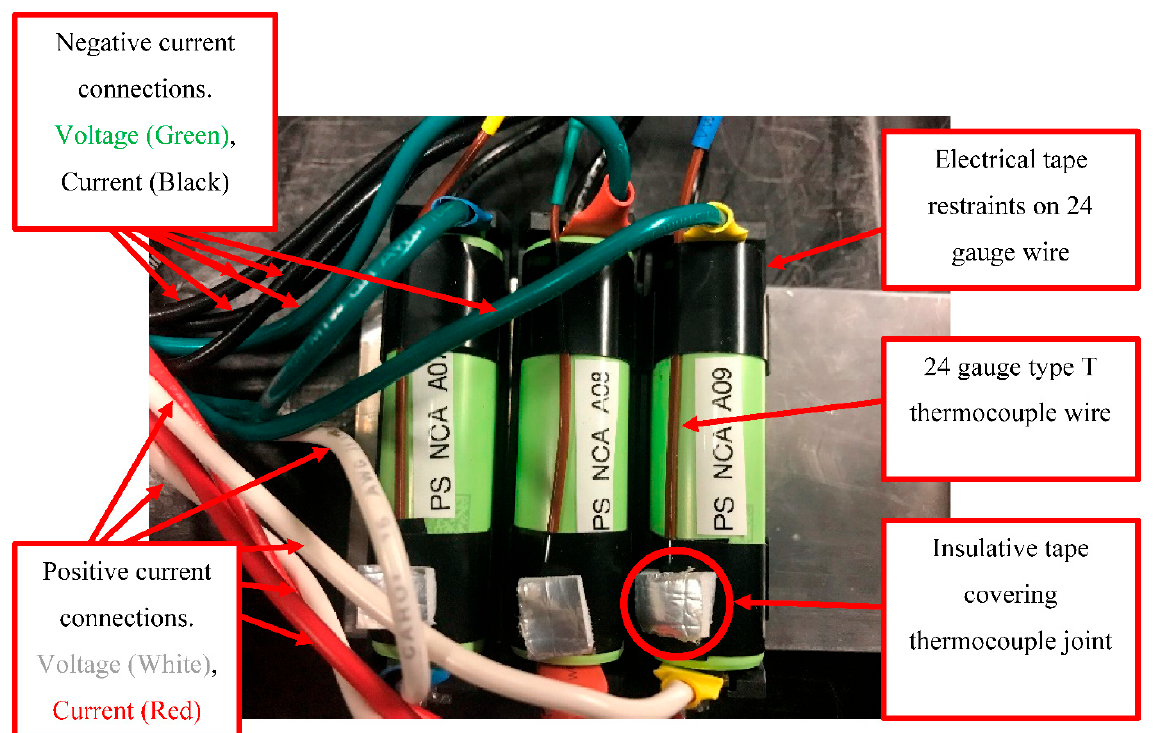
Figure 2. Experimental setup photograph of the interior of thermal chamber, with LEO condition test cells (0.2 kPa, 10 °C) in 3P groupings. Note that the test cells in the standardized condition (101 kPa, 20 °C) and low temperature condition (101 kPa, 10 °C) are not shown.